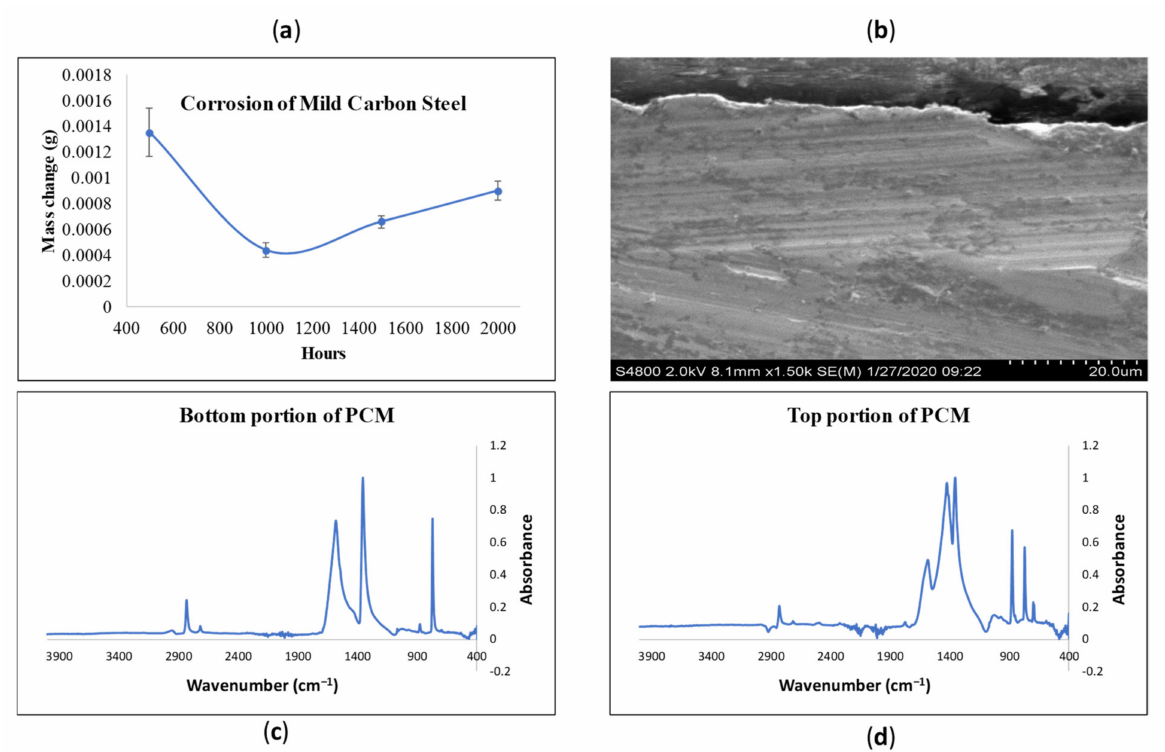
Figure 5. ( a ) Corrosion of mild carbon steel in molten sodium formate. Corrosion data are expressed as average mass change of coupons with standard error over 2000 h, measured at 500-h increments. ( b ) SEM images of cross sectioned carbon steel coupon after 2000-h immersion in molten sodium formate. Magnification 1500 × . ( c ) FTIR of the bottom portion of the PCM after corrosion experiment was completed. ( d ) FTIR of the top portion of the PCM after corrosion experiment was